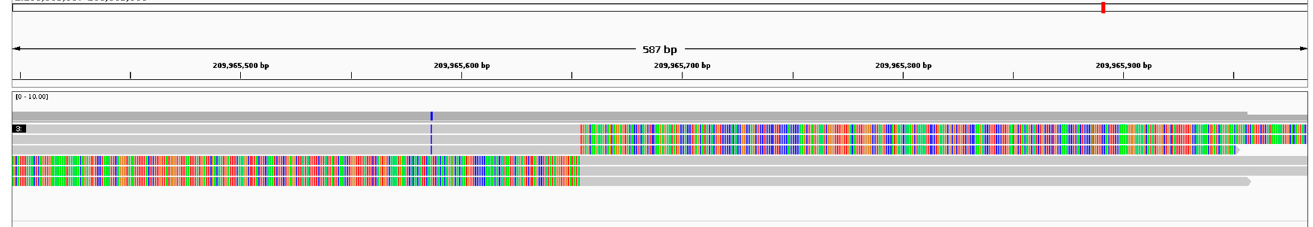
Figure A2. Visualization of rearranged allele sequence generated using SvABA de novo assembly.